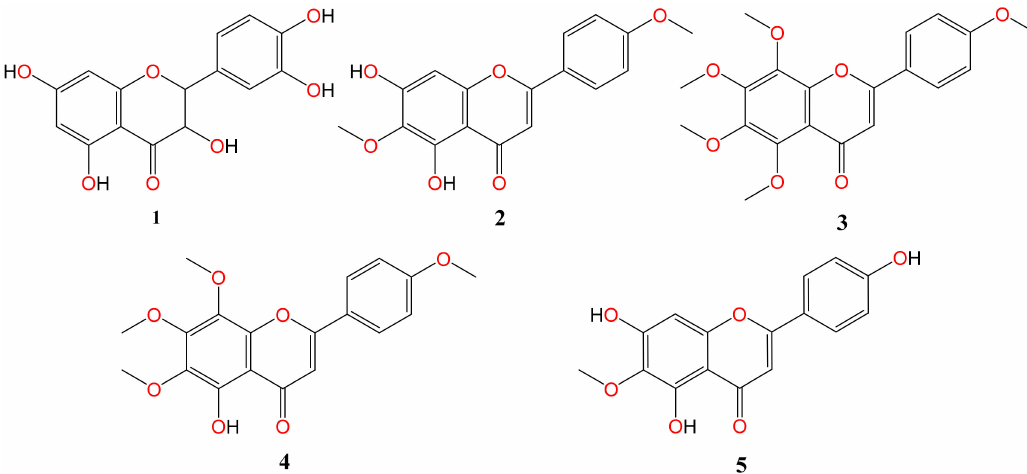
Figure 1. The chemical structures of the isolated flavonoid